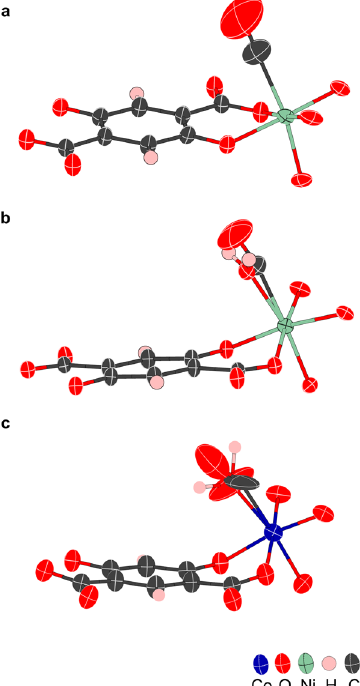
Fig. 2 The asymmetric units of Ni-CPO-27 and Co-4,6-dhip, showing 50% probability ellipsoids, highlighting the binding of CO in the two systems. a Ni-CPO-27 at 450 K with 2.5 bar CO pressure, with 40(4)% CO occupancy. b Ni-CPO-27 at 300 K with 2.5 bar CO pressure, with 63(4)% CO occupancy and 27(3)% water. c Co-4,6-dhip at 500 K with 2.5 bar CO pressure, with 10.7(15)% CO occupancy and 15.2(15)% water